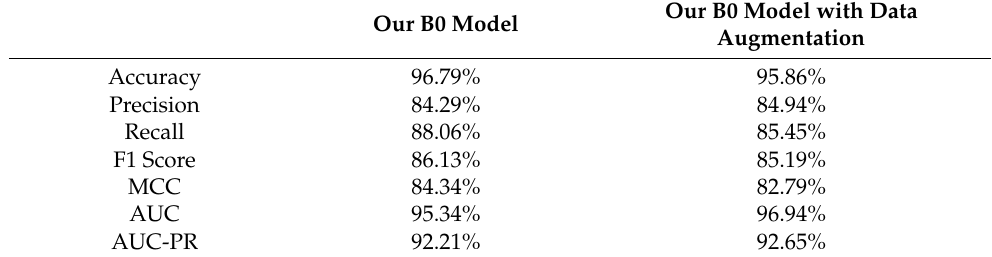
Table 3. Model results.